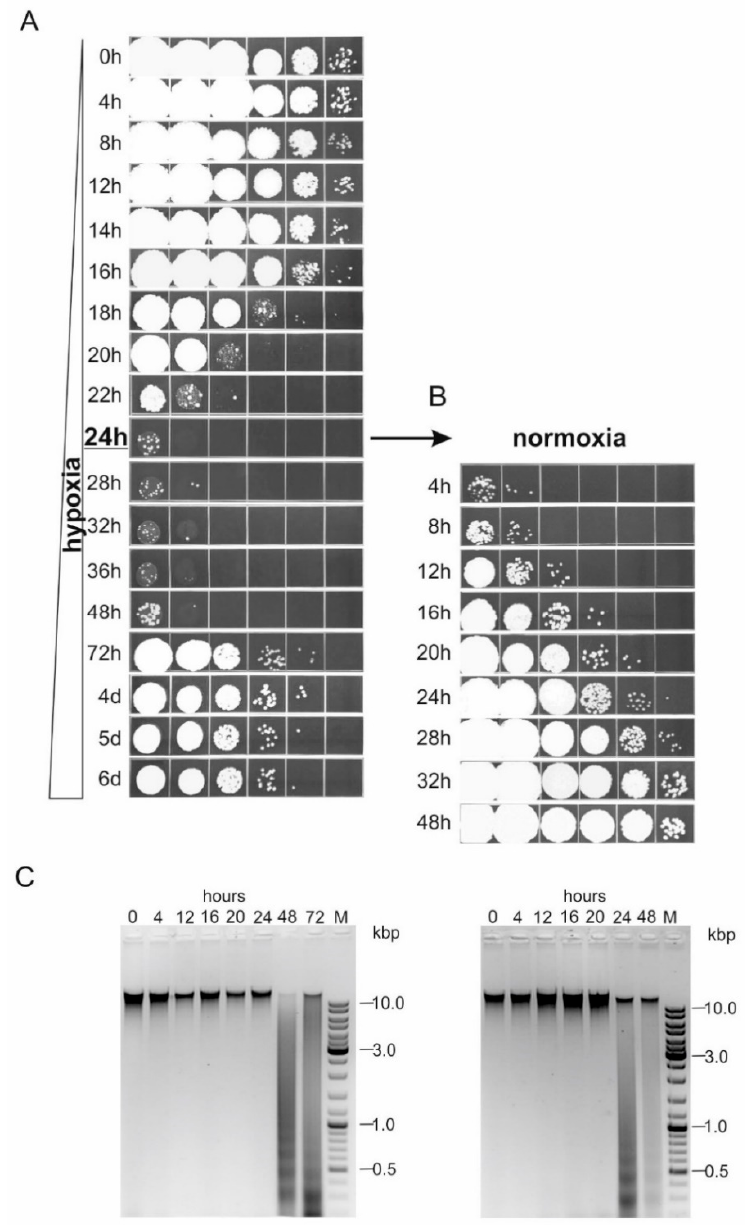
Figure 3. Survival kinetic of U. maydis high-density cell suspension during incubation in water under hypoxic and normoxic conditions. ( A ) 4 × 10 8 cells/mL were incubated in water in 1.5 mL tightly sealed tubes, for induction of hypoxia. At the indicated time-points, a single tube was taken for preparation of 10-fold serial dilutions and spotted on the solid growth medium. ( B ) Cell suspension incubated in 1.5 mL tube for 24 h was further incubated in water in a 50-mL tube (normoxia) and dilutions were spotted at indicated time-points for monitoring of the recovery. ( C ) Agarose gel electrophoresis of genomic DNA extracted from cell suspensions incubated in water for the indicated time intervals under hypoxic ( left ) and normoxic conditions ( right ). M- GeneRuler DNA Ladder Mix, Thermo